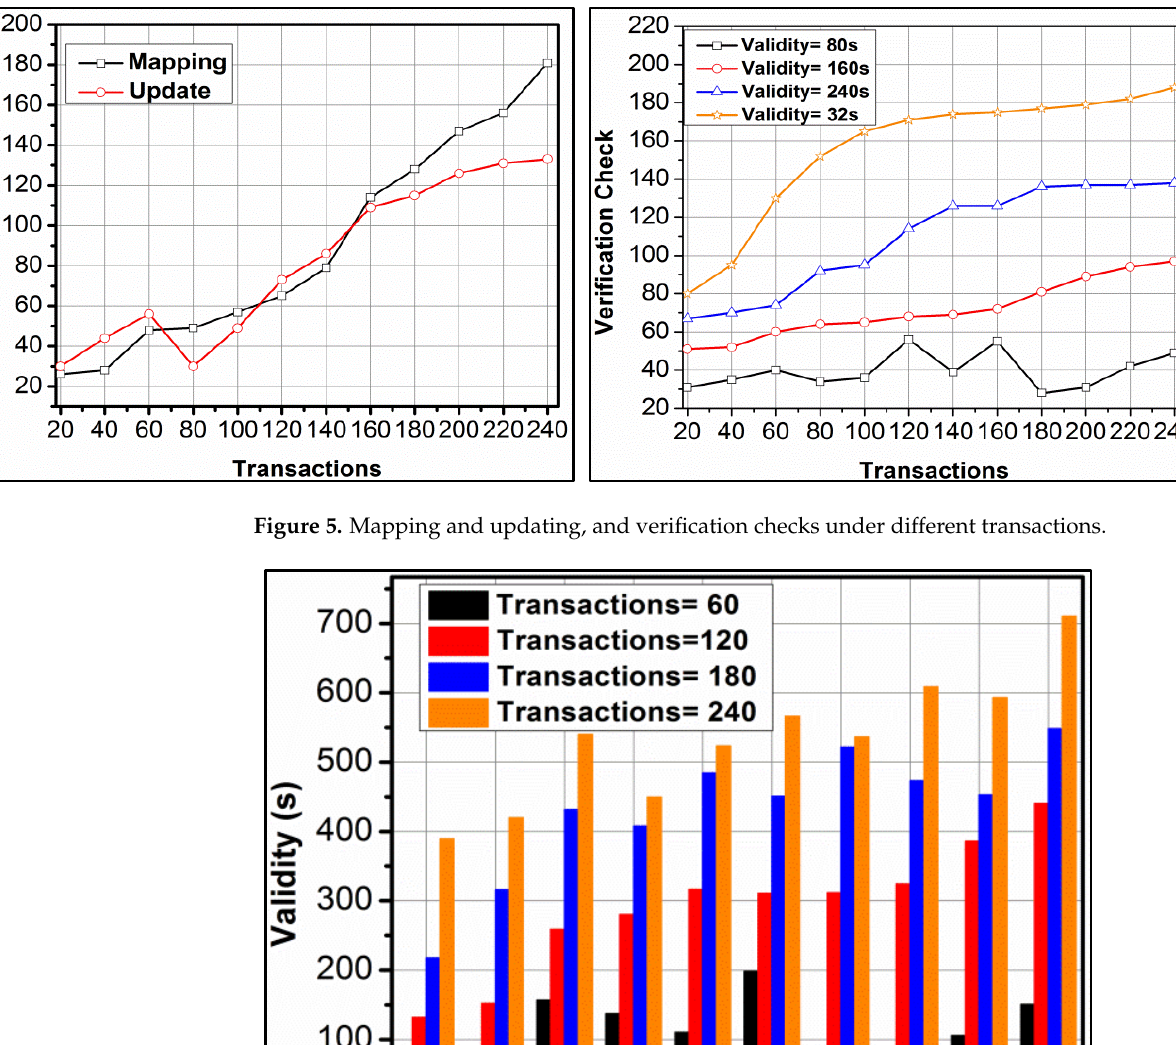
Figure 5. Mapping and updating, and verification checks under different transactions.